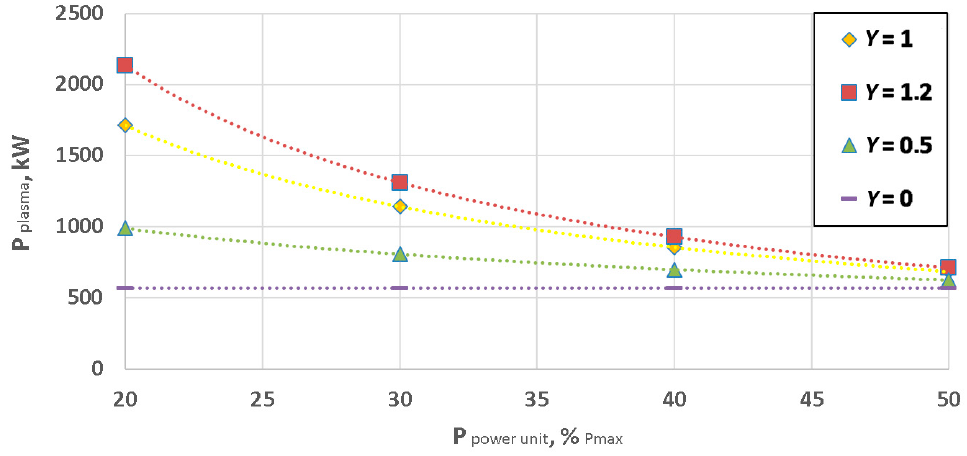
Figure 2. The required power of plasma torches as a function of the relative power of the assumed case of 200 MW el power unit, depending on the assumed Y coefficient.